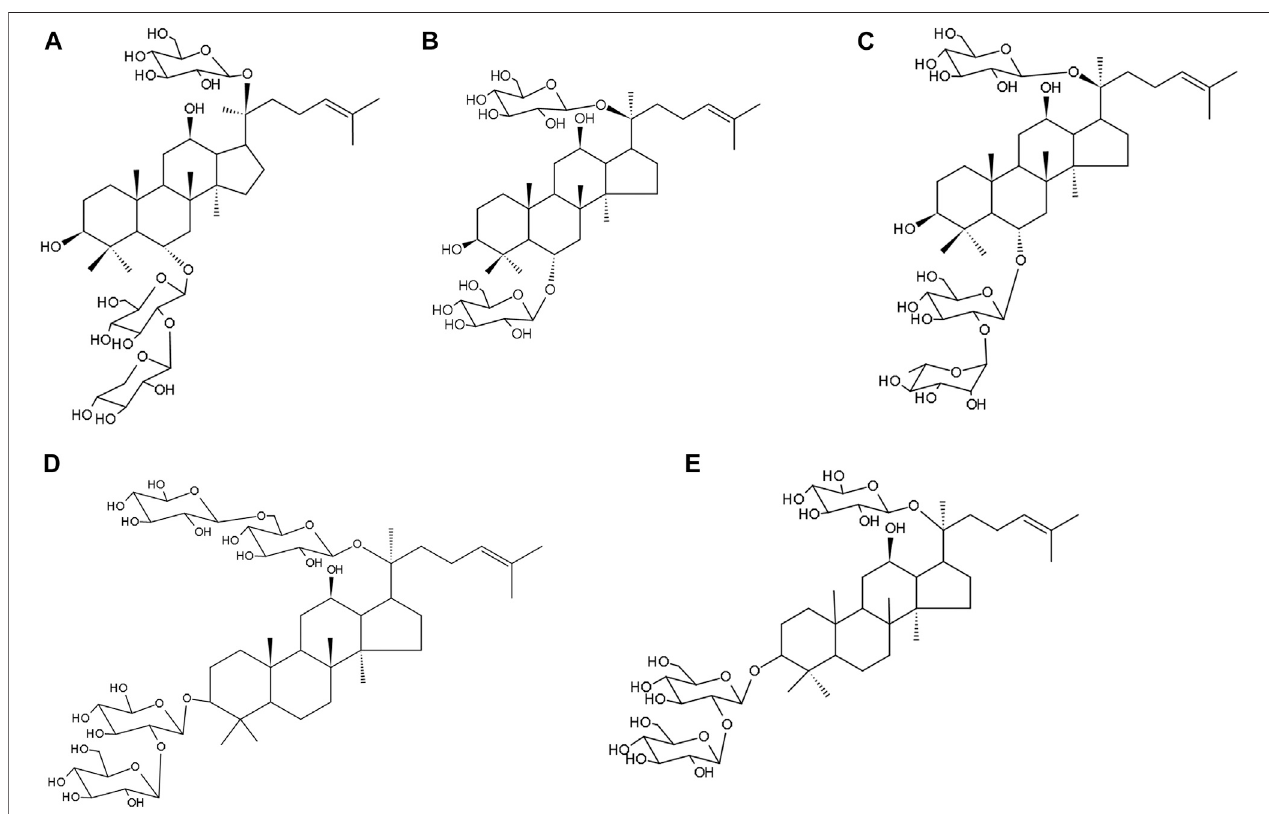
FIGURE 1 | The fi ve major ginsenosides in XueShuanTong and their chemical structures. (A) Notoginsenoside R 1 (12.6%). (B) Ginsenoside Rg 1 (43.5%). (C) Ginsenoside R e (5.6%). (D) ginsenoside Rb 1 (27.8%). (E) ginsenoside R d (2.3%).